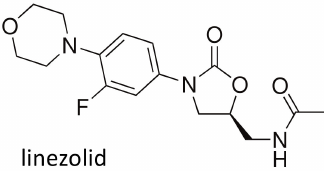
Figure 10. Chemical structure of